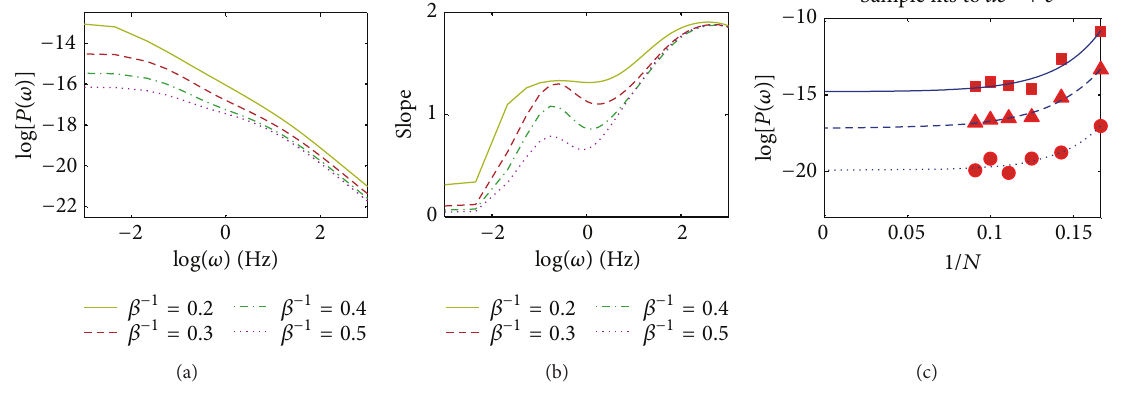
Figure 4: Temperature dependent (a) correlation functions and (b) power spectrum shown in the thermodynamic limit ( 𝑁 → ∞ ). (c) Some samples of best, mediocre, and worst case fits are shown for 𝑁 = 6–11